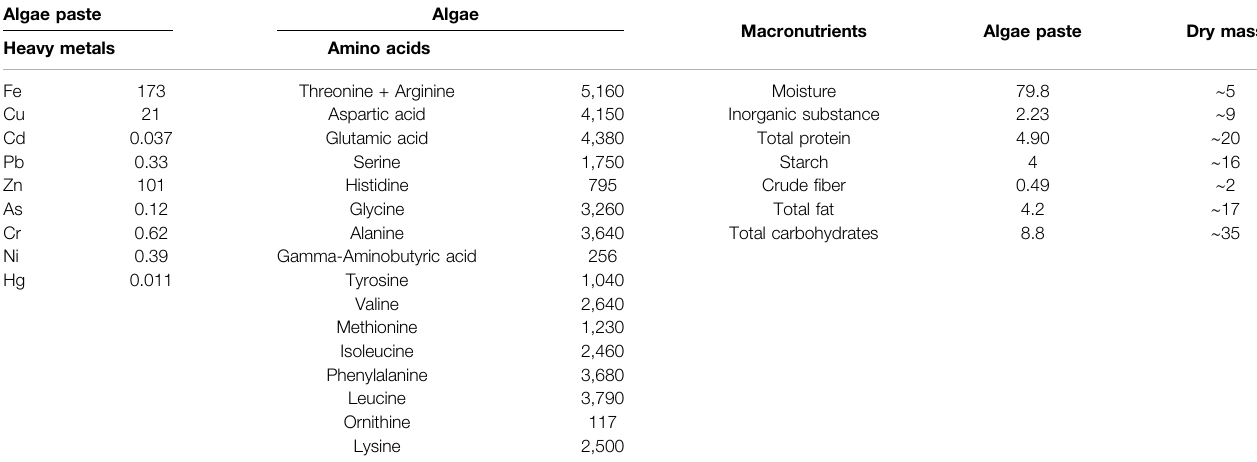
TABLE 4 | Heavy metal (mg kg − 1 ), amino acid (mg kg − 1 ) and macronutrient content (g 100 g − 1 ) of C. sorokiniana paste ( ∼ 80% moisture), cultivated on 50% poultry wastewater diluted with tap water. Macronutrient content in algae paste was extrapolated to relative abundance in dry mass (assuming a 5% moisture level). Algae